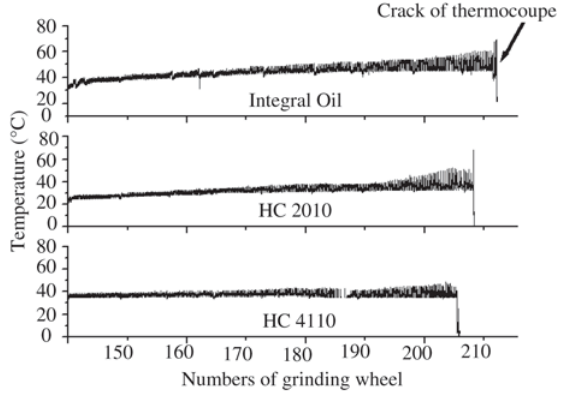
Figure 9. Comparative results of temperatures for the 3 rd thermocouple.